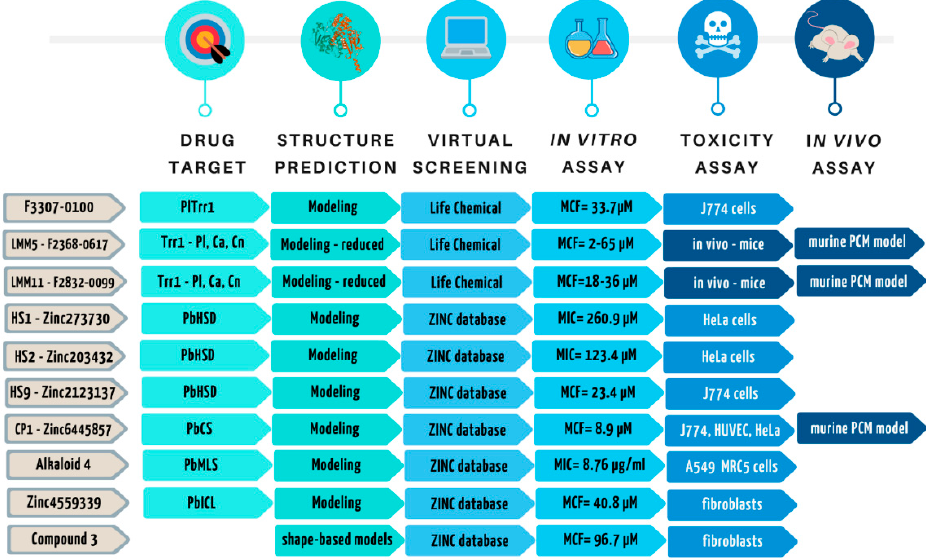
Figure 4. Comparison of selected molecules by virtual screening. Ten different molecules showed promising values of antifungal activity and absent of toxicity in vitro. Only three molecules were tested in an experimental model of paracoccidioidomycosis (PCM). F3307-0100 [114], LMM5 and LMM11 [135], HS1 and HS2 [153], HS9 [140], CP1 [141], alkaloid 4 [146] Zinc4559339 [142], Compound 3